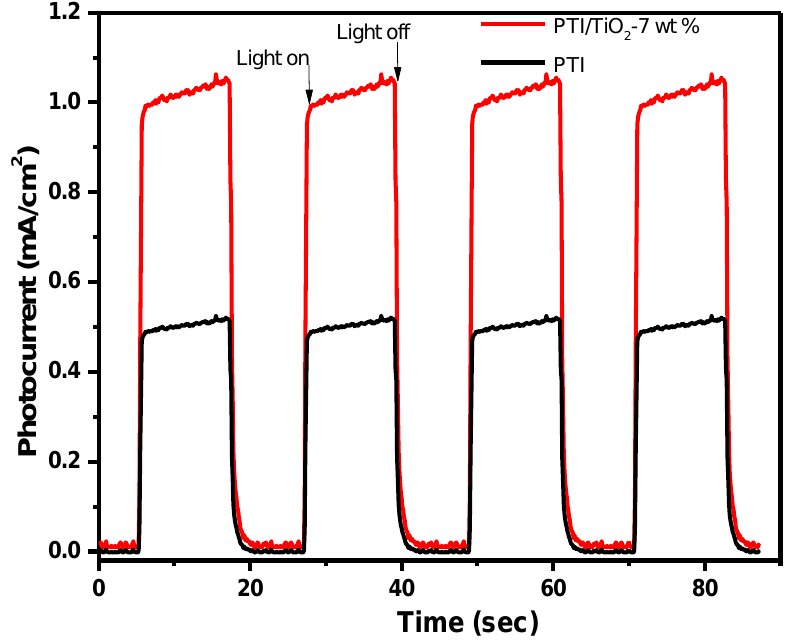
Figure 9. Transient photocurrent response of the PTI and PTI/TiO 2 -7wt% heterojunction.